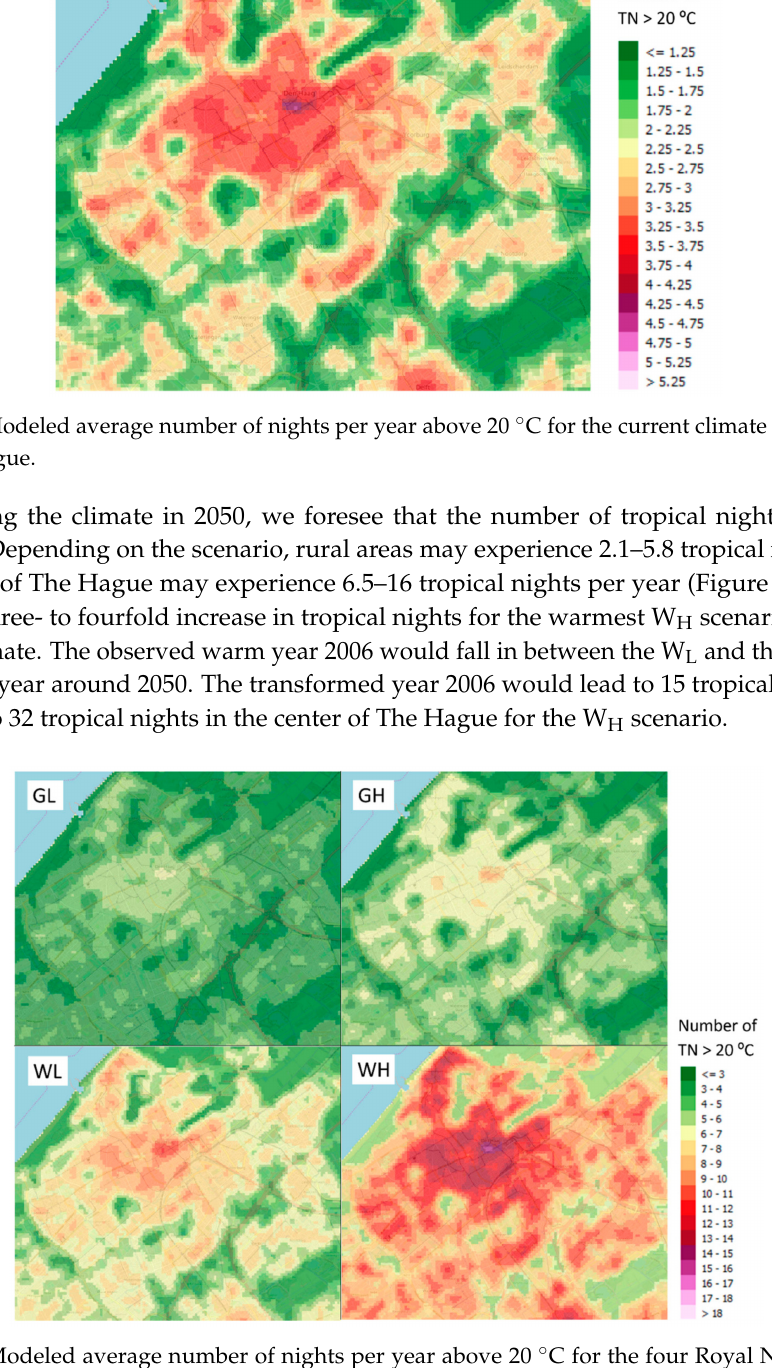
Figure 7. Modeled average number of nights per year above 20 ◦ C for the four Royal Netherlands Meteorological Institute (KNMI’14) scenarios representing the year